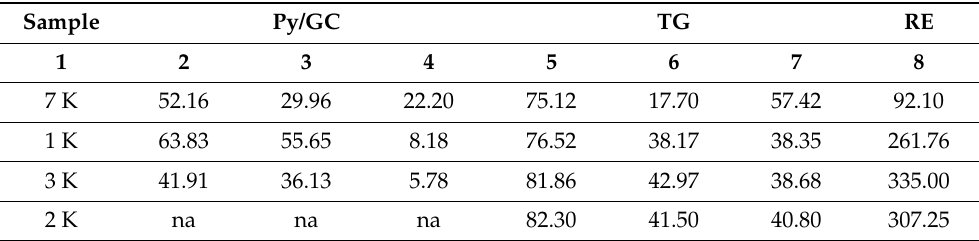
Table 3. Comparison of the weight loss of kerogen samples separated from Menilite Beds in the three-stage Py/GC and TG analyses.